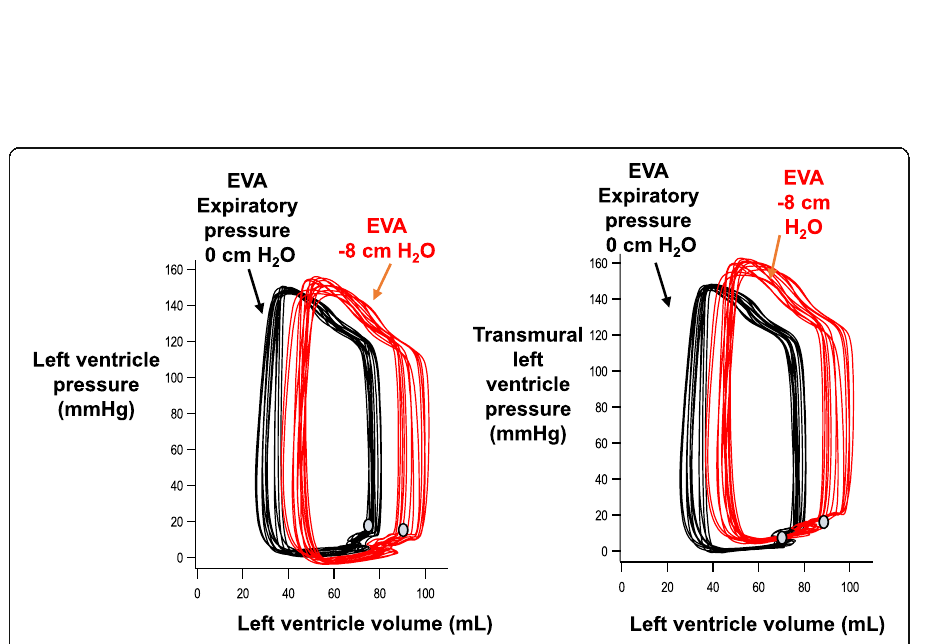
Fig. 7 Pressure-volume loops from one subject during expiratory ventilation assistance (EVA). The left panel shows a decrease in measured left ventricular end diastolic pressure (gray circles) as expiratory pressure decreases. The right panel shows the same data, but with an estimate of transmural left ventricle pressure on the Y -axis. This demonstrates that negative expiratory pressure with EVA increases left ventricular wall